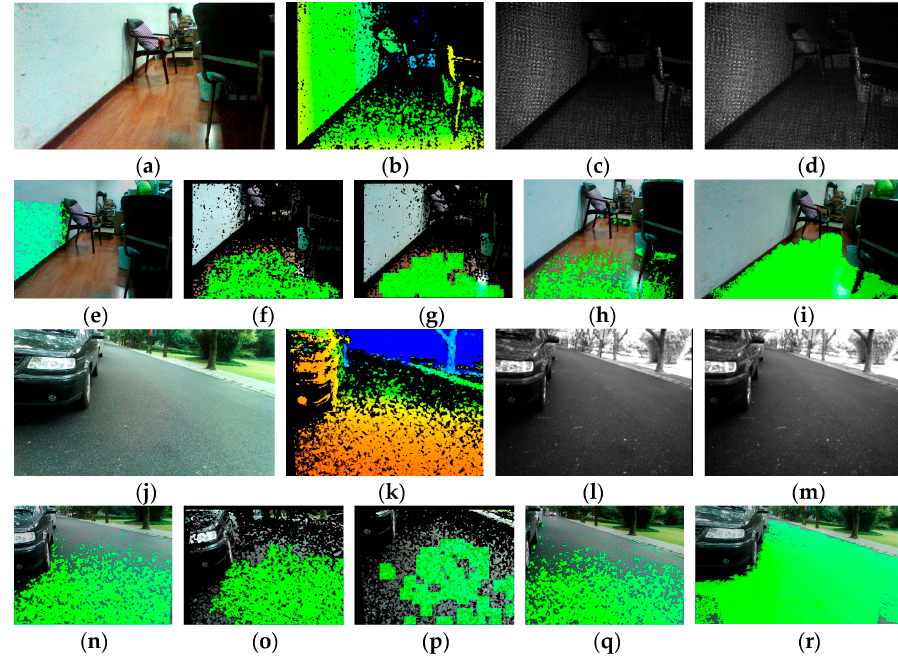
Figure 10. Comparisons of results of different traversable area detection approaches. ( a – d ) The set of images of a typical indoor scenario including color image, depth map, and calibrated IR pairs; ( e – i ) the results of different approaches on the indoor scenario; ( j – m ) the set of images of a typical outdoor scenario; and ( n – r ) the results of different approaches on the outdoor scenario.